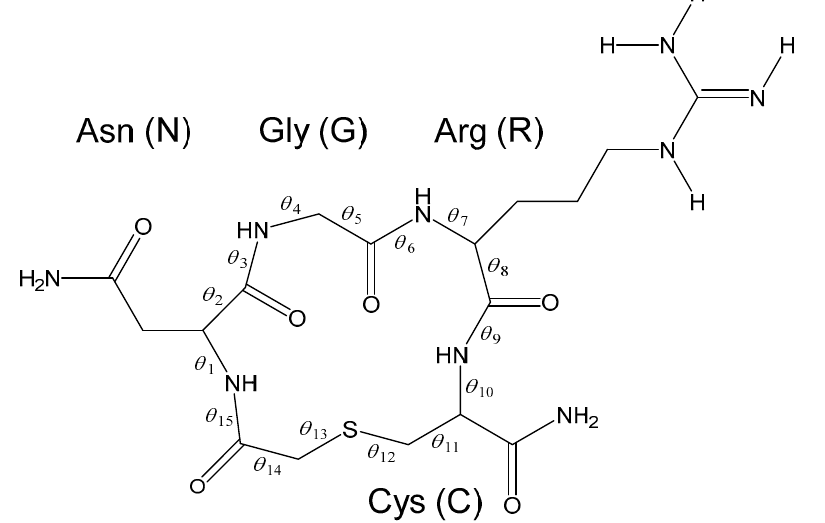
Figure 1. A 15-membered cyclic peptide, c[CH 2 CO-NGRC]-NH 2 , containing the NGR (Asn-Gly-Arg) motif. This peptide is called CP15 in this paper. The guanidino group of the Arg side chain is depicted as a deprotonated form (see text for details). The definition of the heavy-atom dihedral angles θ 1 – θ 15 for the 15-membered ring are also shown.